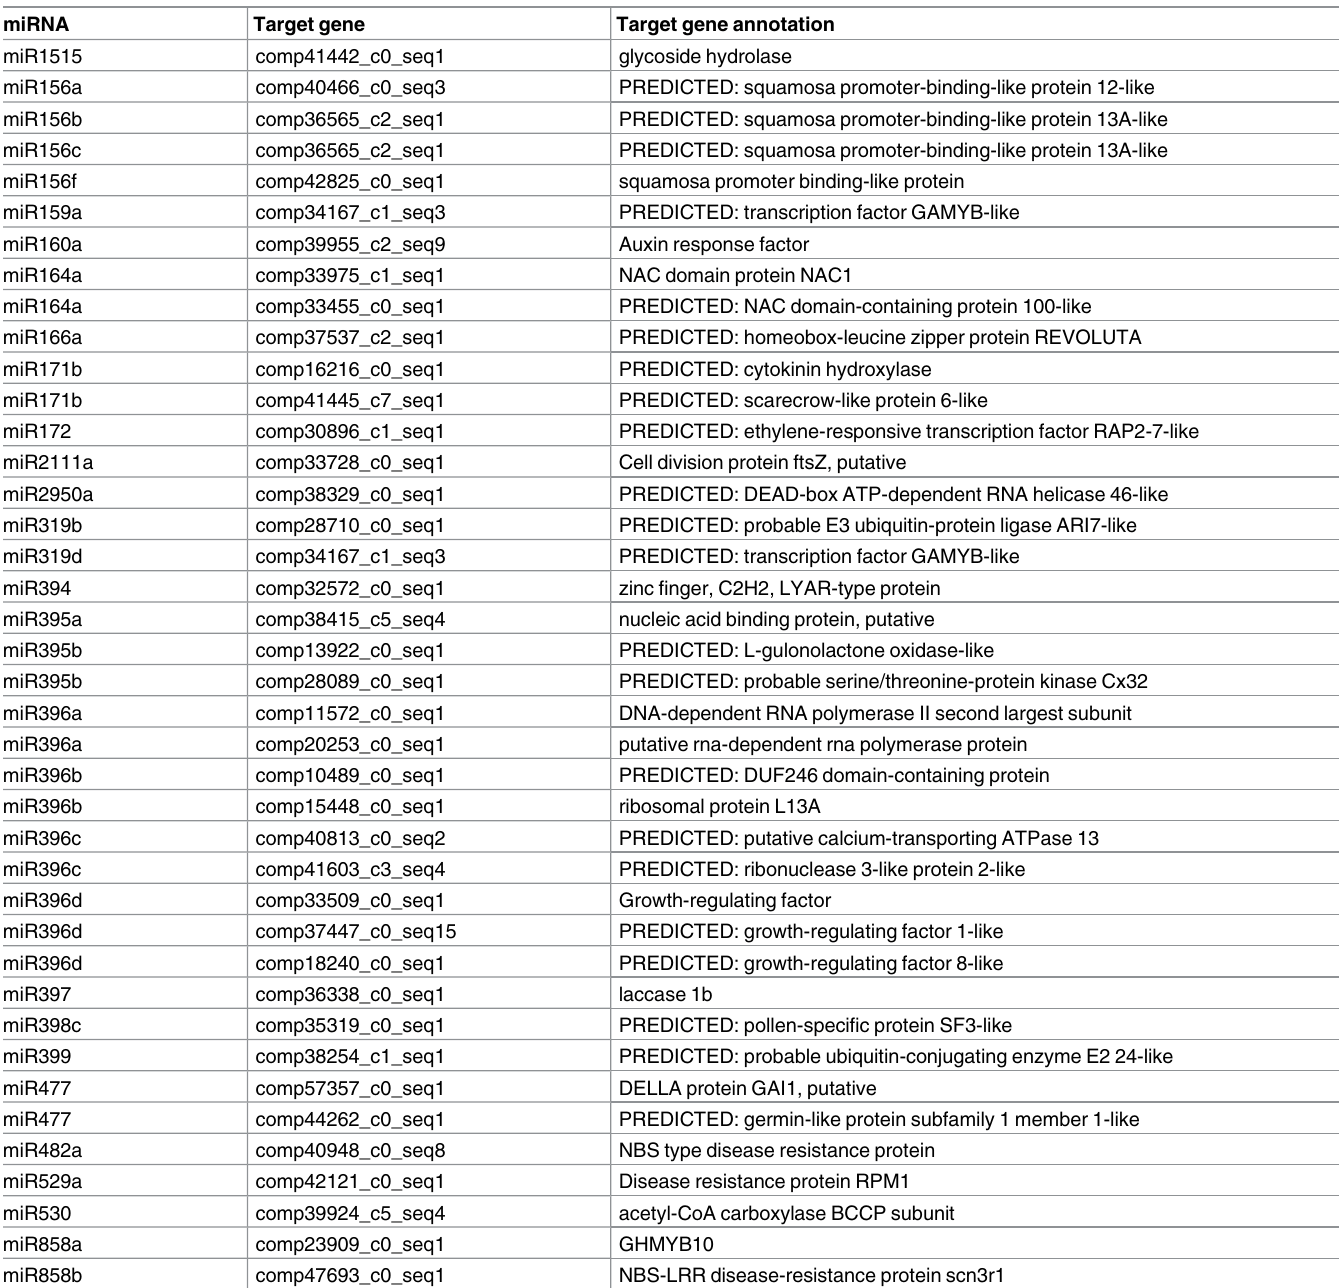
Table 4. The predicted conserved miRNAs targets of Z . jujuba